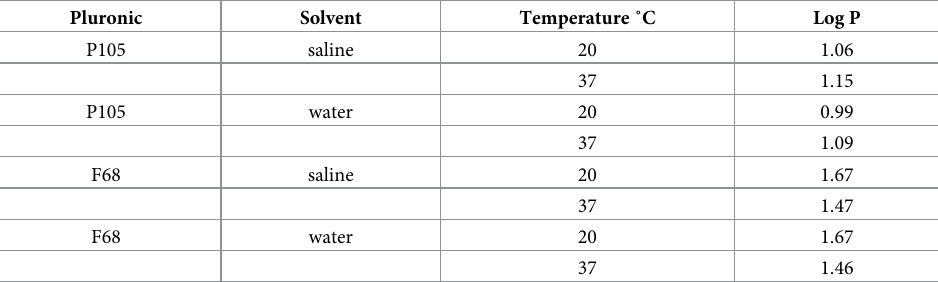
Table 5. The fraction of pentamidine incorporated into the Pluronic micelle expressed as a partitioning coeffi- cient, P. The Pluronic was dissolved in pure water (aqueous) or saline (saline) at 20˚C and 37˚C. (Also see Fig C in S1